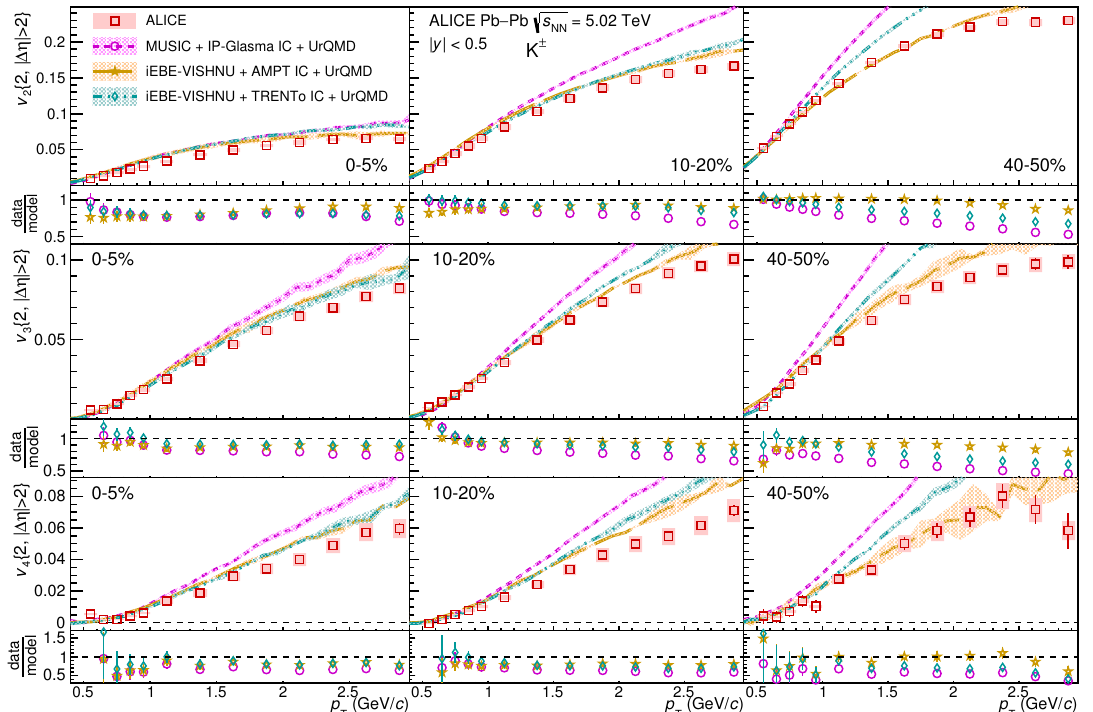
0.511.5 ode l a da t Figure 13 . (Colour online) The p T -di(cid:11)erential v 2 (top), v 3 (middle), and v 4 (bottom) of K (cid:6) for the 0{5%, 10{20%, and 40{50% centrality classes compared to hydrodynamical calculations from MUSIC model using IP-Glasma initial conditions (magenta) [82] and the iEBE-VISHNU hybrid model using AMPT (orange) or TRENTo (cyan) initial conditions [83]. Statistical and systematic uncertainties of the data points are shown as bars and boxes, respectively. The uncertainties of the hydrodynamical calculations are depicted by the thickness of the curves. The ratios of the measured v n to a (cid:12)t to the hydrodynamical calculations are also presented for